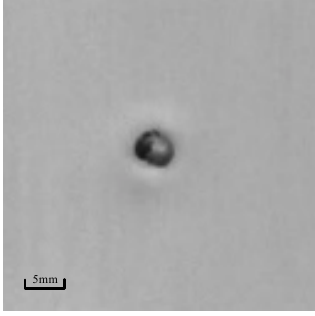
Figure 14. Pores defect. Table 9. Confusion matrix with the addition of pores